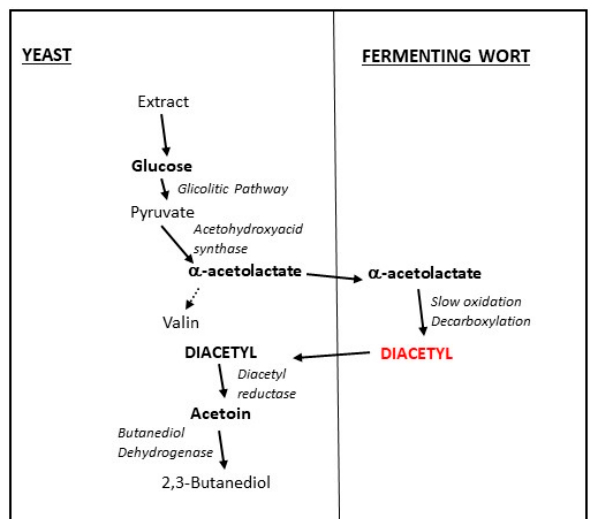
Figure 3. Diacetyl metabolism pathway: Yeast cells in the fermenting wort internalize the soluble sugars and activate the glycolytic pathway. Pyruvate is converted into α -acetolactate that is expelled from the cell and converted to diacetyl, which can remain in the final beer or be reabsorbed and converted into the non-flavour 2,3-butanediol. This figure was adapted from Kobayashi et al. (2005)